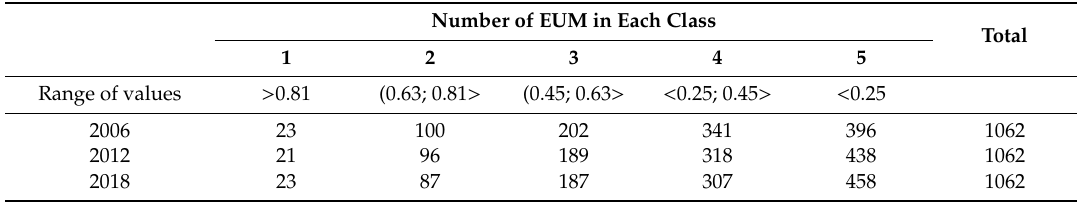
Table 2. Classes of the LCC indicator.